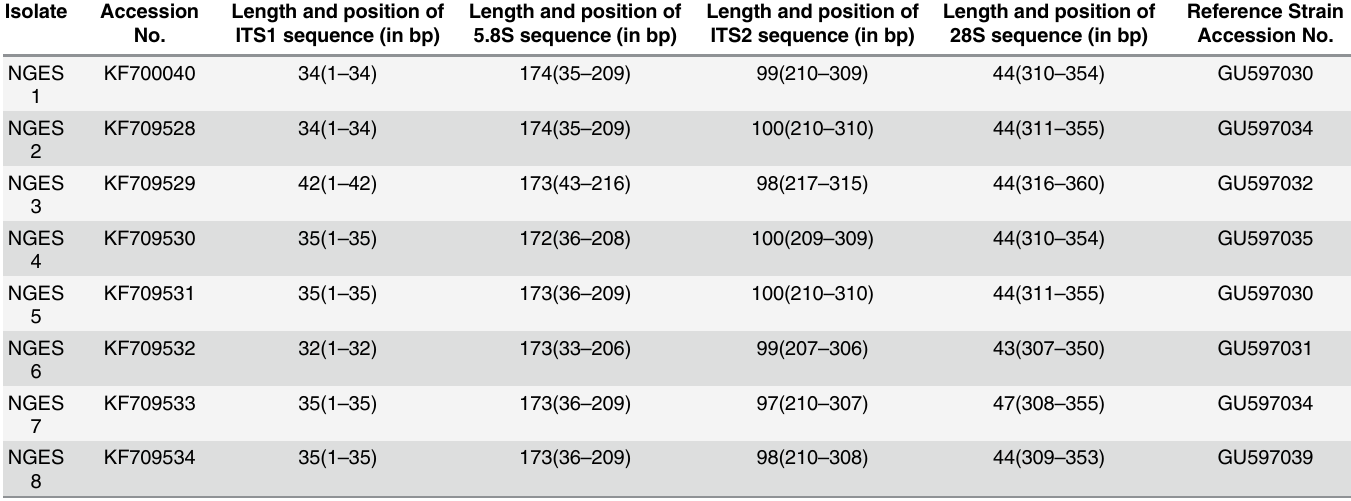
Table 3. Length and position of base in the ITS-5.8S-ITS2-28S sequence of the selected isolates (NGES1- NGES10). Isolate Accession